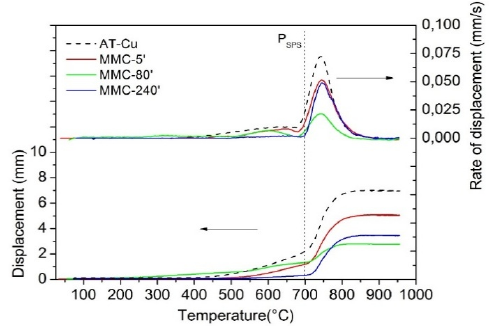
Figure 5. Displacement and displacement rate curves of AT ‐ Cu, MMC ‐ 5 ′ , MMC80 ′ , and MMC ‐ 240 ′ .